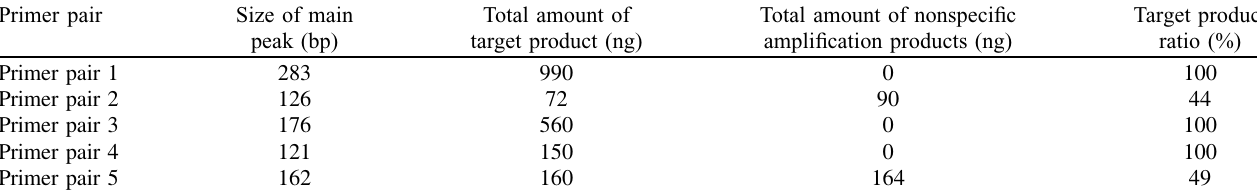
Table 2. Ampli fi ed products of the 5 pairs of primers by Qsep100 bioanalyzer test. Primer